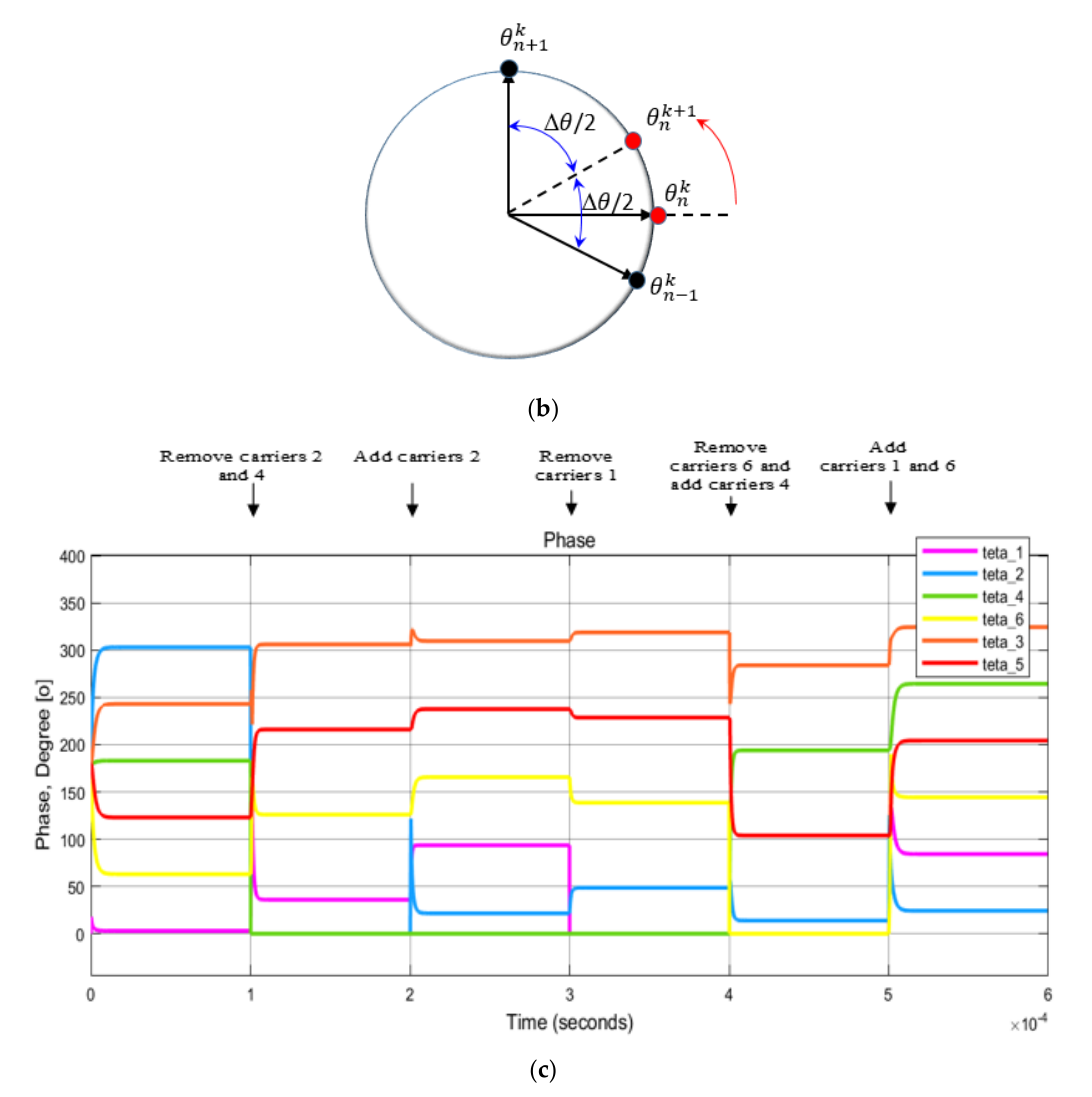
Figure 2. Conventional decentralized method for multiphase converters, ( a ) intercellular communication; ( b ) basic iterative updating rule principle; ( c ) multiple reconfiguration.